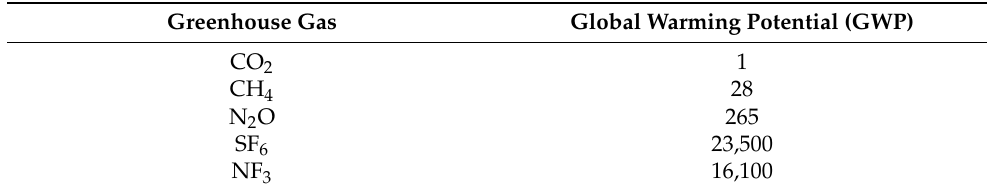
Table 5. Global warming potential of greenhouse gases.